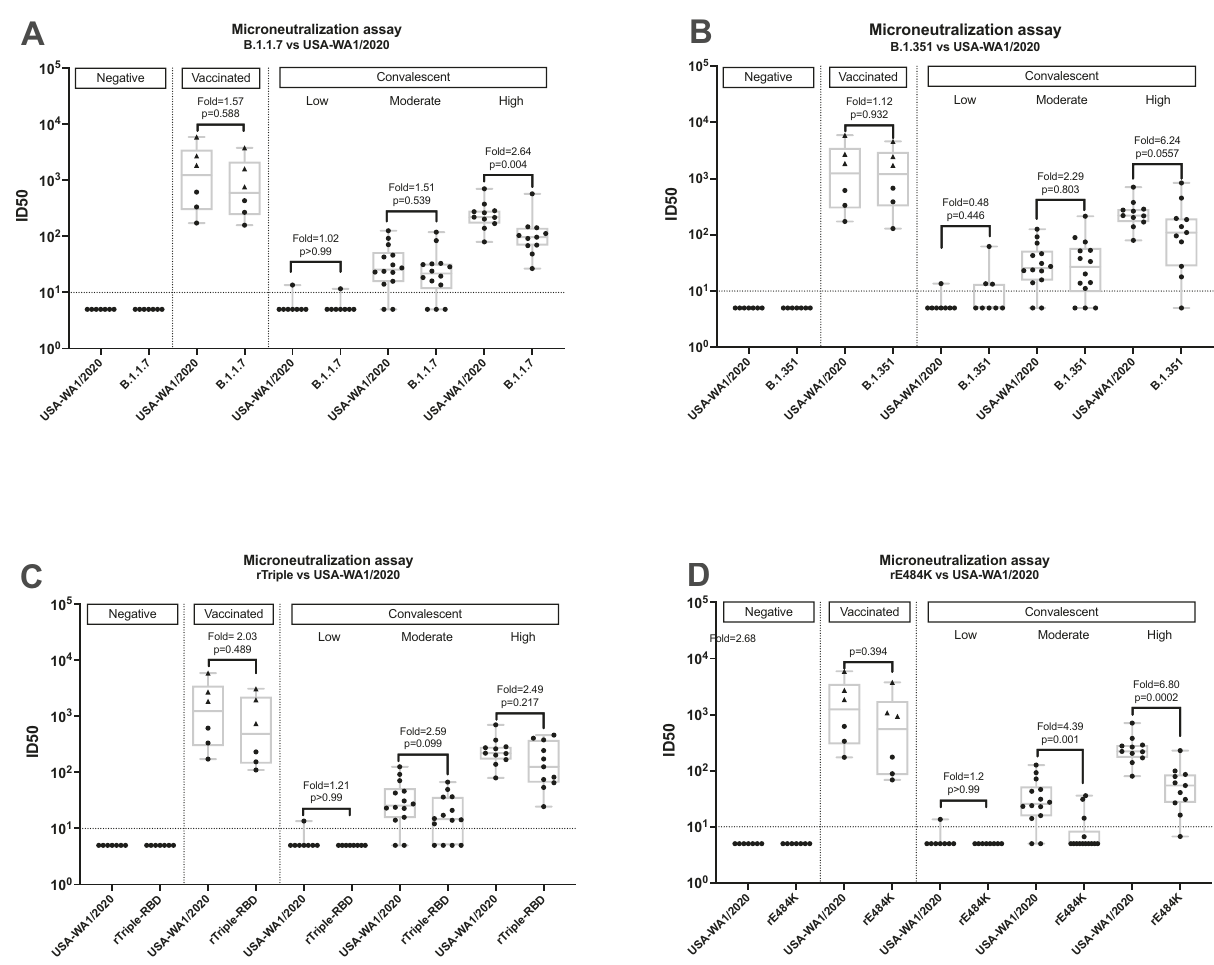
Fig. 9 Comparison of in vitro serum microneutralization titers between WT-SARS-CoV-2 (USA-WA1/2020) and B.1.1.7, B.1.351, rTriple- and rE484K- SARS-CoV-2. Box and whisker plots represent median and range of low-to-high value points in each group. The samples are divided into three groups- negative, vaccinated, and convalescent depending on their vaccination status or previous exposure to SARS-CoV-2 [negative ( n = 7) versus weak ( n = 8), moderate ( n = 13), and strong positive ( n = 18)]. Negative group corresponds to individuals with naïve serum in terms of vaccination or SARS-CoV-2 exposure. Vaccinated samples belong to individuals who received two doses of P fi zer/BioNTech vaccine irrespective of previous exposure to SARS-CoV-2 (convalescent and corresponding convalescent + vaccinated individuals are represented as ▴ ). Convalescent group is further subdivided into low, moderate and high based on their Spike-speci fi c IgG titres. ID50 values for USA-WA1/2020 are compared to those for B.1.1.7 ( A ), B.1.351 ( B ), rTriple ( C ) and rE484K ( D ). Two-sided Mann – Whitney U tests were performed to calculate statistical differences. The box-whisker plots show all minimum to maximum data points, with respective medians and interquartile range. The fold change was calculated individually for each sample and represented as average fold change for each group. Dotted line (LOD). Source data are provided as a Source Data fi